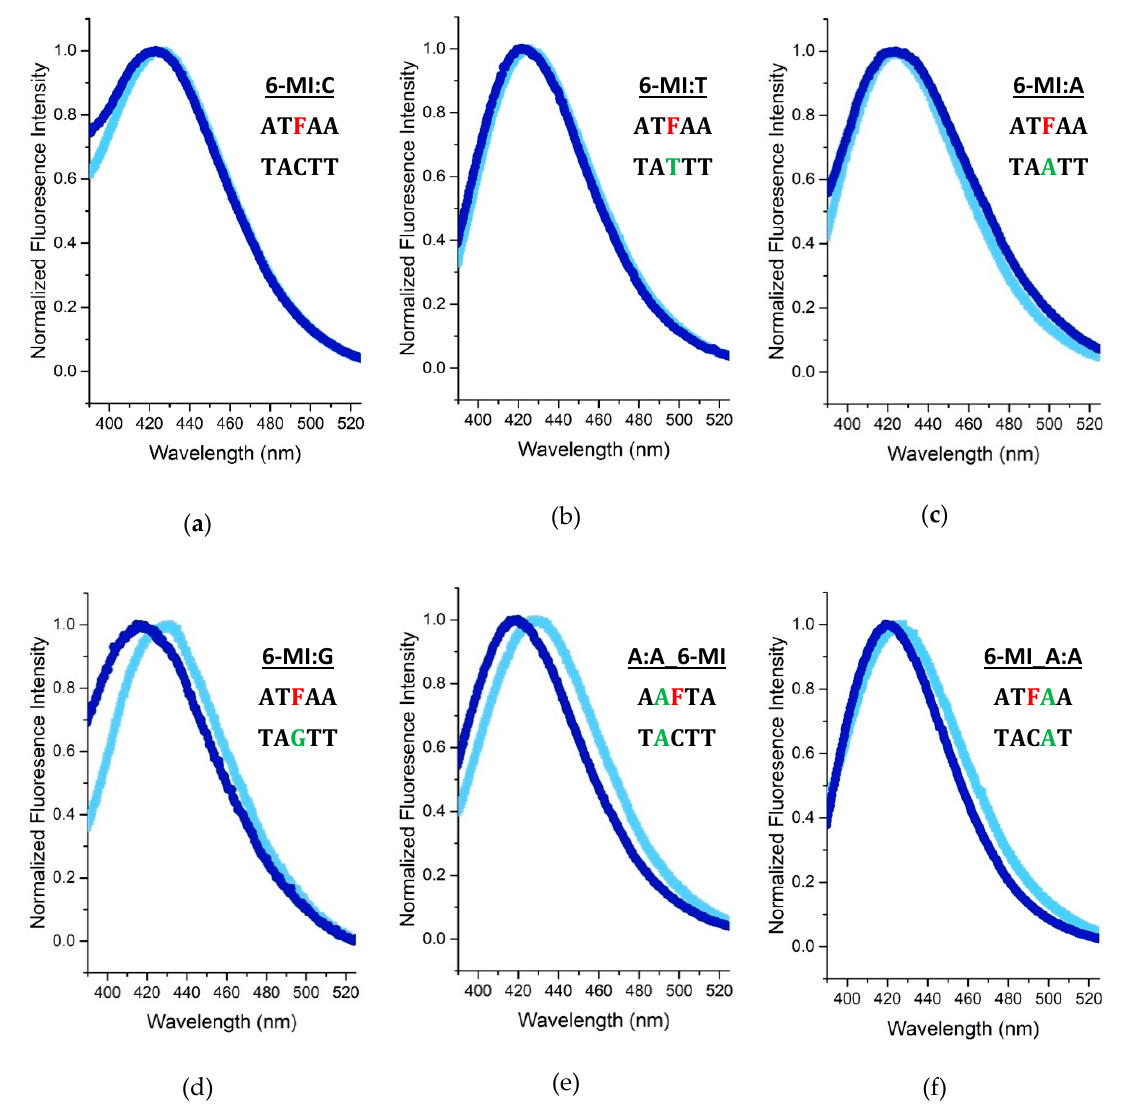
Figure 5. 6-MI Spectral Blue Shifts Report on Msh2-Msh6 Preferred Binding Orientation and Phe Intercalation. The 6-MI emission spectra of mismatched DNA duplexes with (dark blue) and without (light blue) Msh2-Msh6 protein. Protein binding induces a shift to shorter wavelengths for some